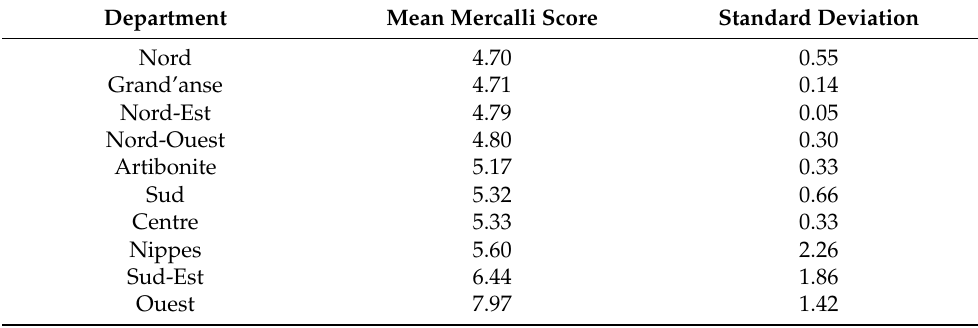
Table 1. Average scores of the Mercalli earthquake Haiti 2010 by